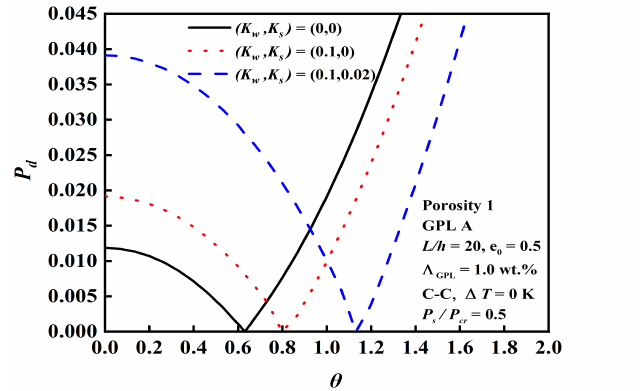
Figure 17. Effect of the foundation stiffness on dynamic instability.